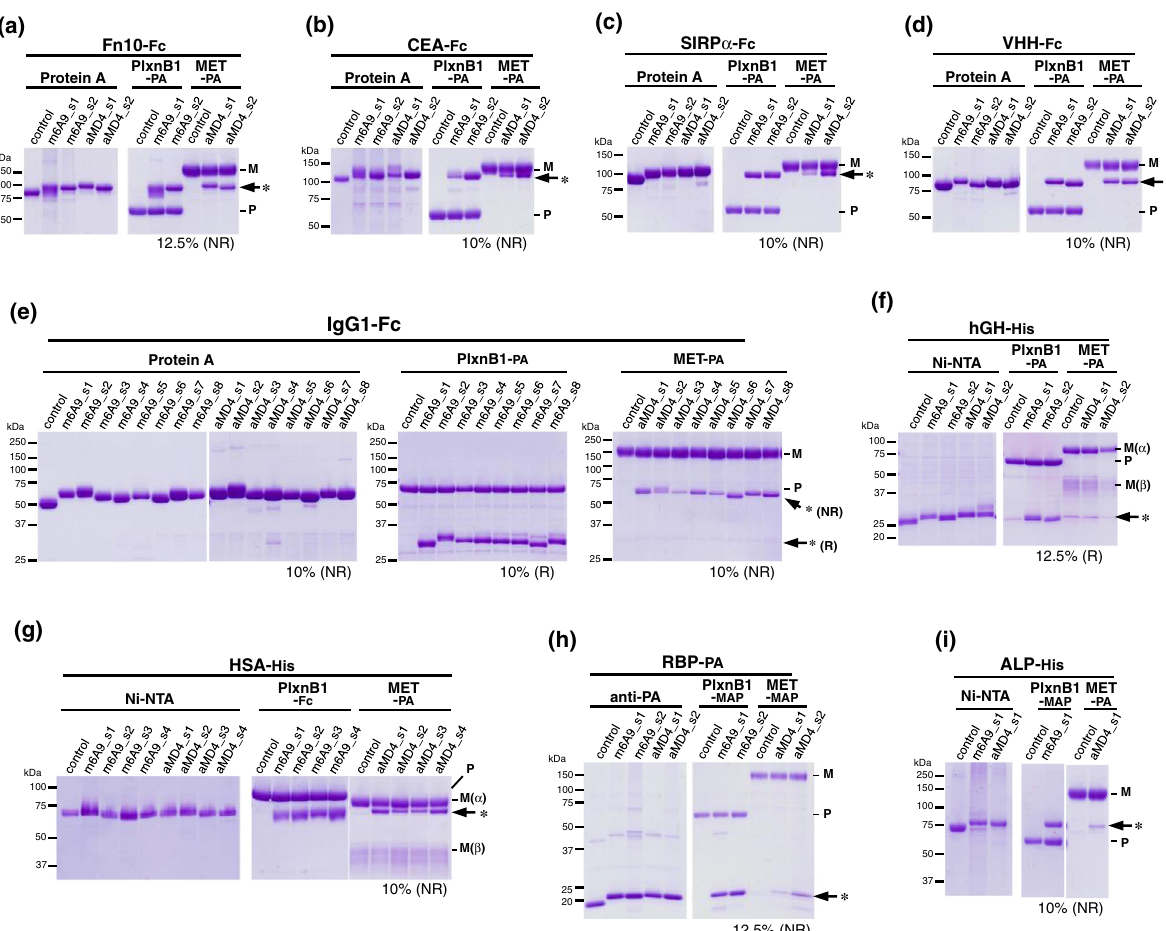
Fig. 3 Lasso-grafting of binder peptides into various protein scaffolds. Nine different protein scaffolds including Fn10-Fc ( a ), CEA-Fc ( b ), SIRP α -Fc ( c ), VHH-Fc ( d ), IgG1 Fc ( e ), hGH ( f ), HSA ( g ), RBP ( h ), and ALP ( i ) were grafted with m6A9 (PlxnB1 binder) or aMD4 (MET binder) peptides at different sites. In the labels, each graft design is denoted as peptide name_insertion site , e.g., m6A9_s4. Expression and secretion of these grafts and non-grafted protein controls, were checked by pulldown experiments (left half of each panel) using beads conjugated with Protein A (for Fc-containing proteins, a – e ), Ni-NTA (for His-tagged proteins, f , g , i ), or the anti-PA tag antibody NZ-1 (for PA-tagged proteins, h ). The same set of samples were subjected to pulldown using PlxnB1- or MET-bound beads (right half of each panel), see Methods section for details on preparing beads bound via af fi nity tag (including PA, MAP, and Fc) to PlxnB1 and MET ectodomain fragments. Coomassie-stained SDS-PAGE gels loaded with protein eluted from beads and run under non-reducing (NR) conditions, except for those gels run under reducing (R) conditions to avoid overlapping bands between the grafted proteins and MET or Plxn. The acrylamide concentration in the gel and the running conditions (NR or R) are indicated below each gel image, and migration positions for MET(M), PlxnB1 (P), and the grafted proteins (*) are shown on the right. Data are representative of at least two independent experiments. Uncropped gel images are provided in the Source Data fi